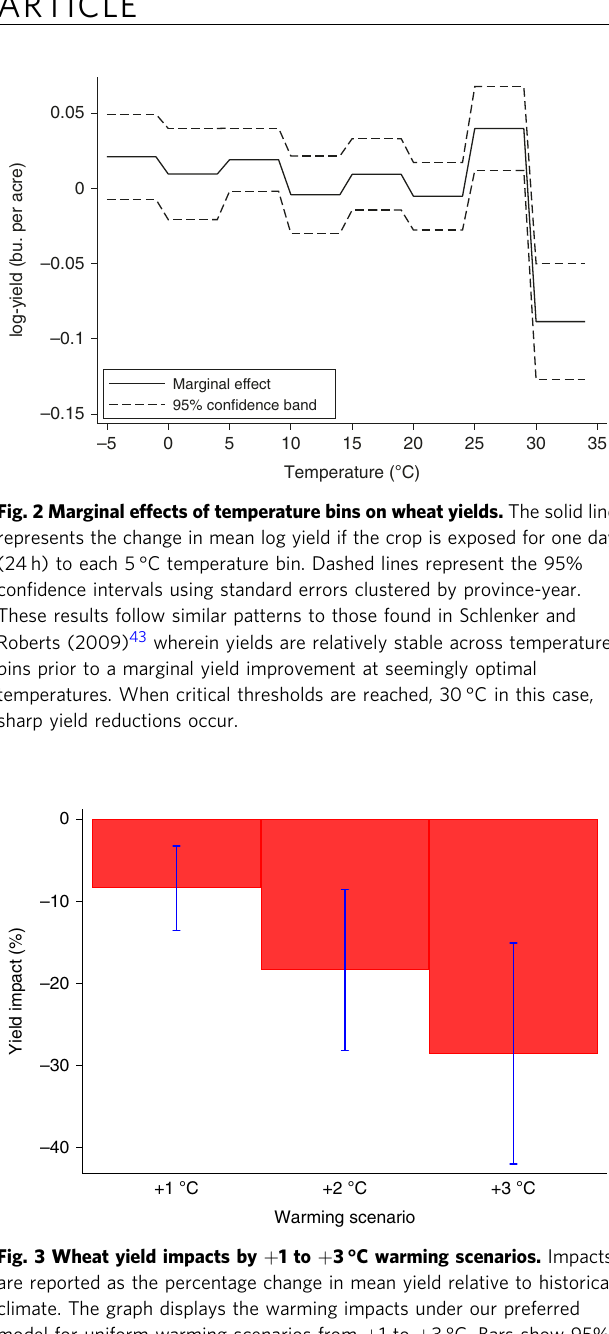
To investigate this, we allow the effect of temperatures above 30 °C to vary by interacting it with a dummy variable for pre- cipitation outcomes below the 10th percentile of the rainfall distribution for these data. The estimates indicate a slightly higher heat effect in the low precipitation regimes as we would expect but the interaction effect is not statistically signi fi cant under a two-tailed test (t(30) = 0.79, p = 0.38), and the implied warming estimates are similar to the ones for our preferred model (Fig. 4).